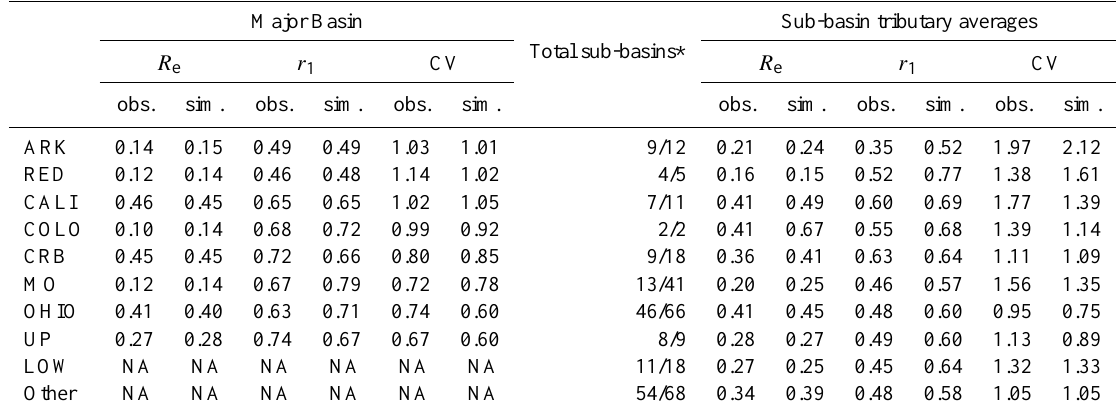
Table 5. Variability analysis for observed followed simulated trends by major basin and tributary averages over a 70-yr period, including runoff efficiency, R e , lag-1 autocorrelation, r 1 , and the coefficient of variation,